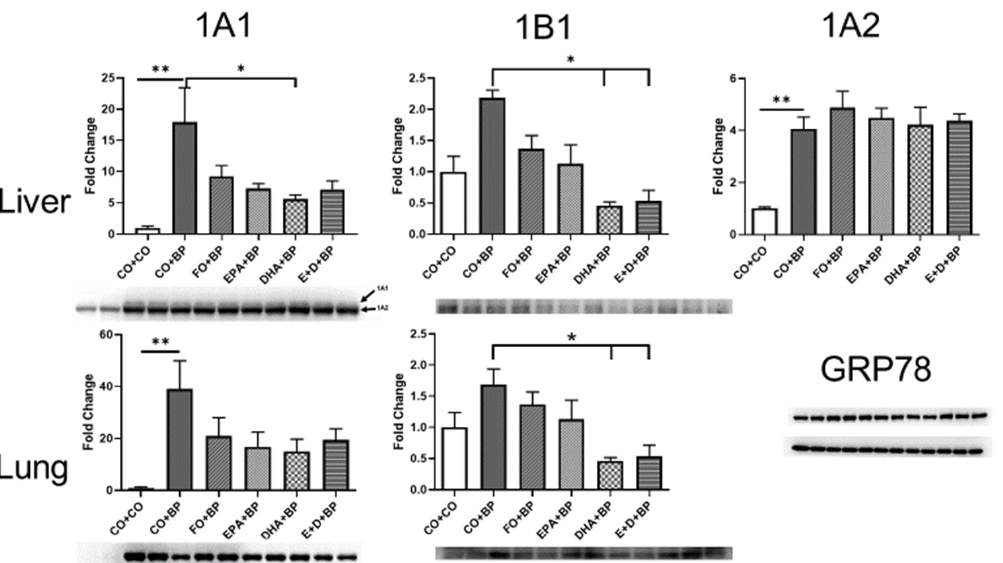
Figure 7. Proteins isolated from liver and lung of mice, fed with CO, FO, EPA, DHA, EPA/DHA and treated with BP, were probed with Cyp1A1, 1B1 or 1A2 (liver only) antibodies by Western blot. FO, DHA and EPA + DHA significantly inhibited Cyp1b1 compared to CO group. Hepatic Cyp1A2 induced by BP treatment was also inhibited by FO, EPA, and DHA. *, p < 0.05, **, p < 0.01, ( n = 5).